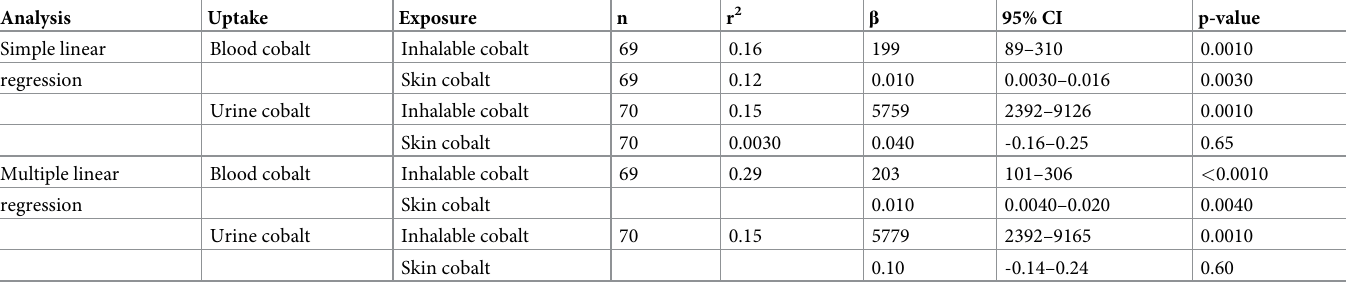
Table 7. Linear and multiple linear regression analysis between exposure, inhalable cobalt adjusted for the use of respirators and cobalt on skin, and uptake of cobalt in blood and urine.